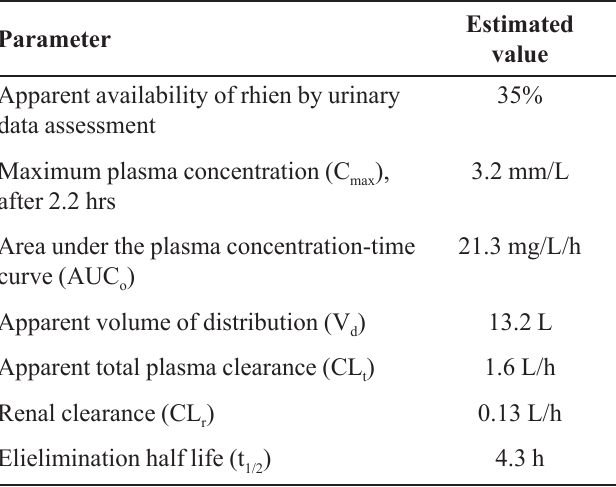
Estimated value